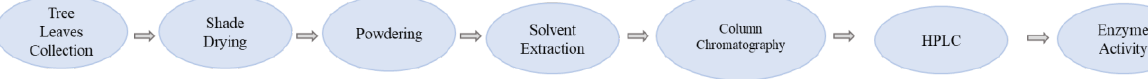
Figure 4. Main operational steps of plant extraction to enzyme